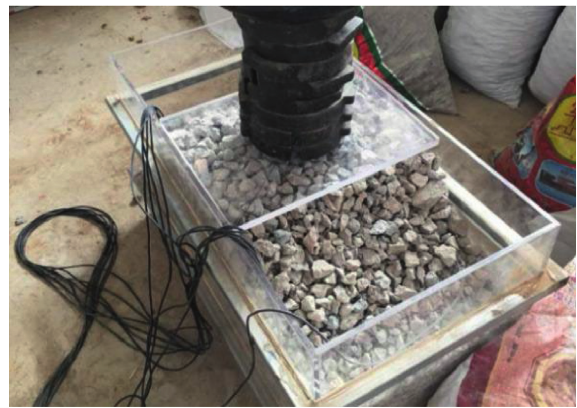
Figure 8: Loading of weights.